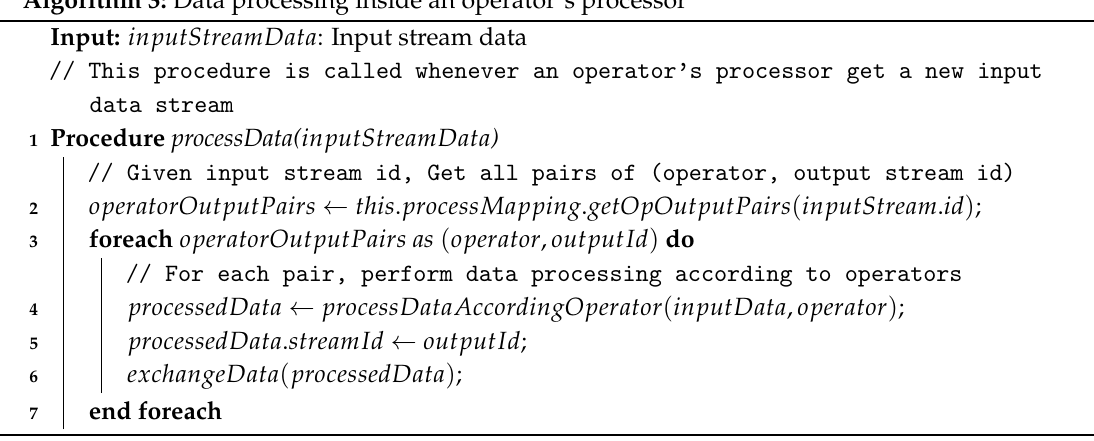
Algorithm 3: Data processing inside an operator’s processor